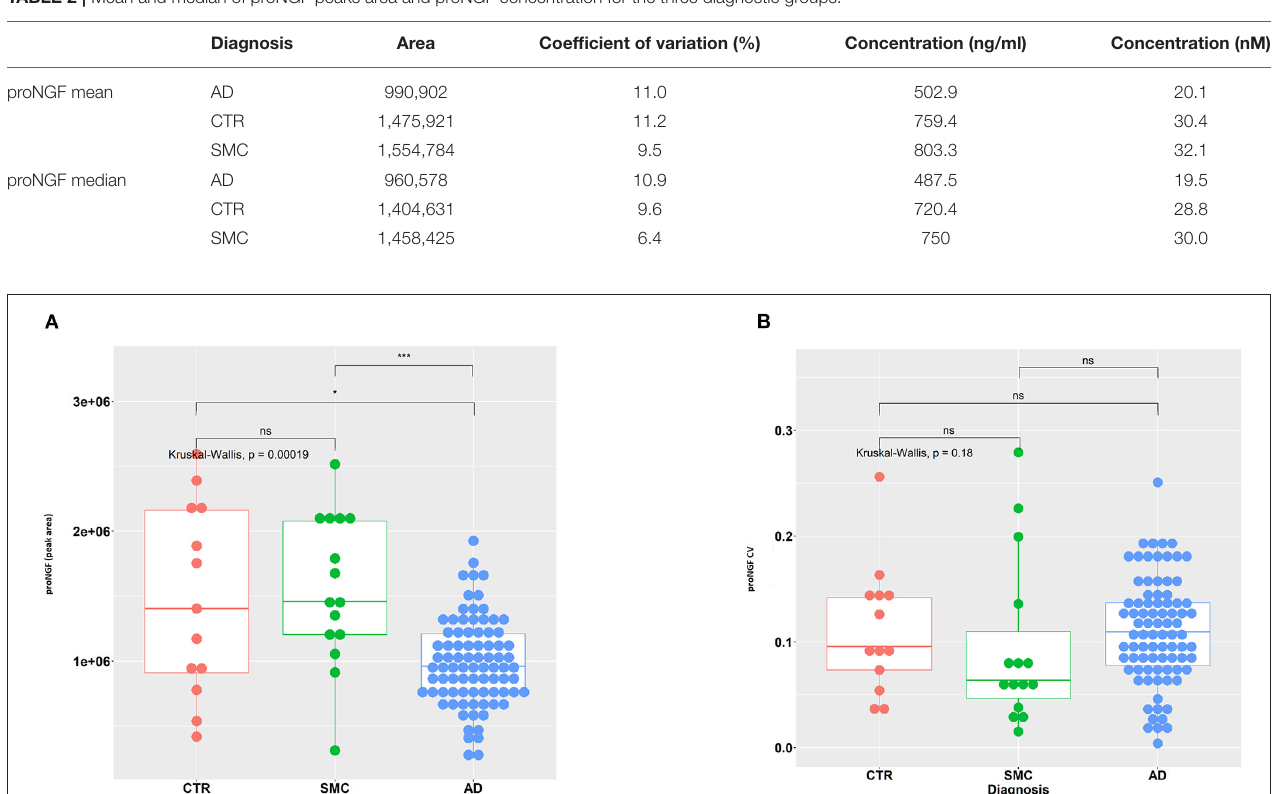
FIGURE 2 | Statistical analysis of proNGF in the CSF samples. (A) A measure of proNGF (peak area) in the three diagnostic groups. Kruskal–Wallis test is followed by pairwise Mann–Whitney test with p -value correction (horizontal bars). The difference in data dispersion between groups was analyzed by the variance F -test. (B) Coefficient of variation (SD/mean) for proNGF measures in the three diagnostic groups. Kruskal–Wallis test is followed by pairwise Mann–Whitney test with p -value correction (horizontal bars). (*) p < 0.05,(***) p < 0.0001, for post-hoc test.